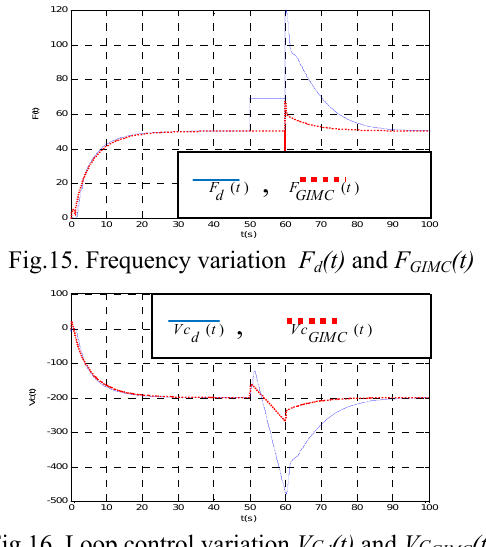
Fig.16. Loop control variation V C